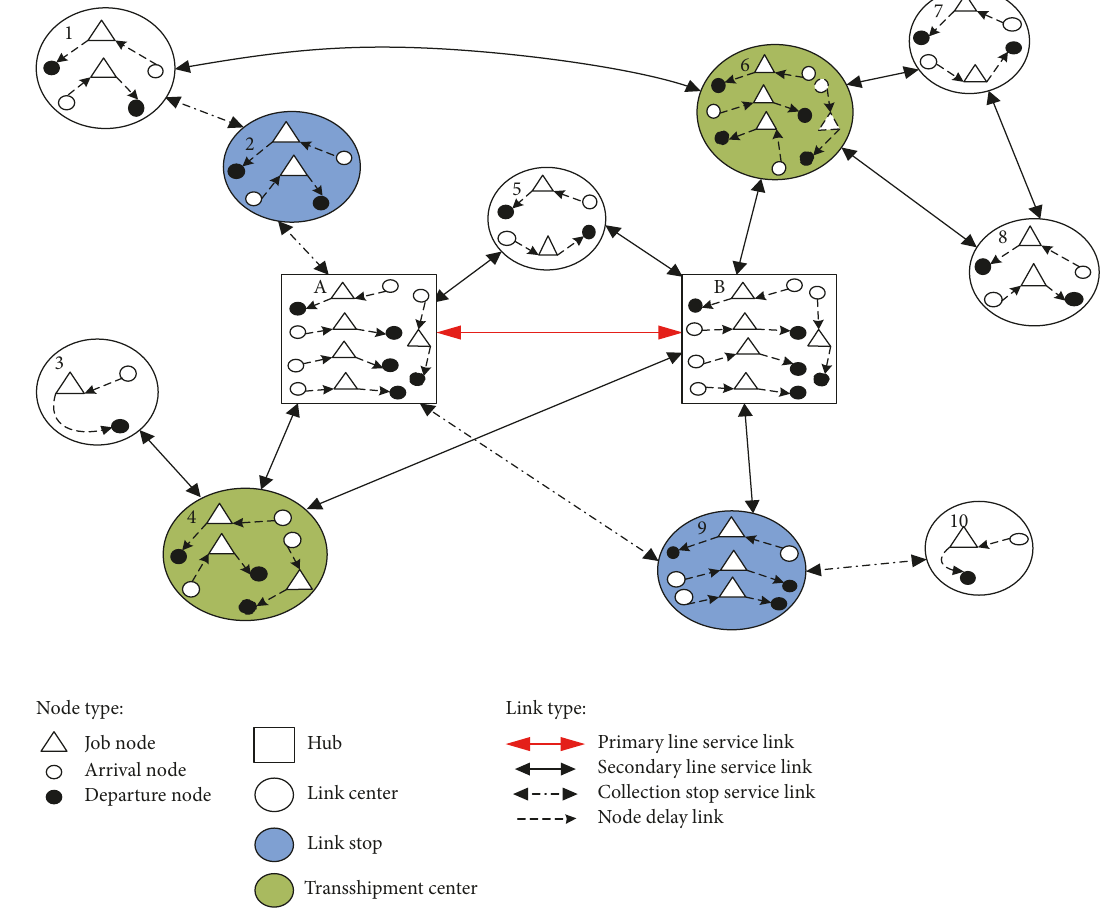
Figure 2: Decomposed HPTB-EPS